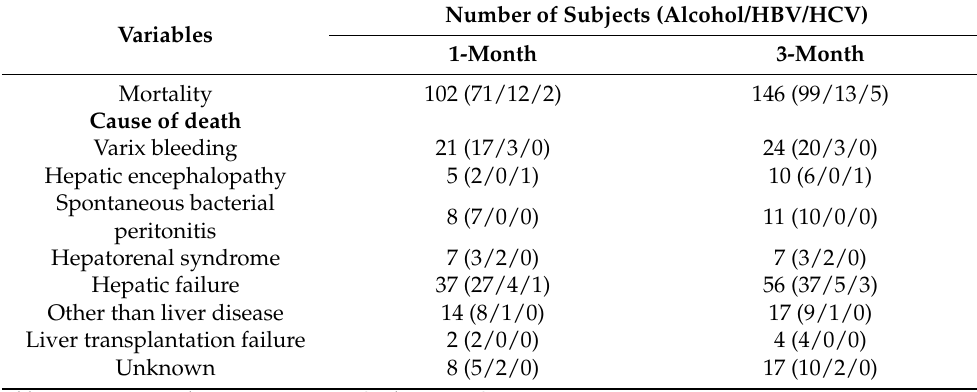
Table 2. One- and three-month mortality and causes of death.